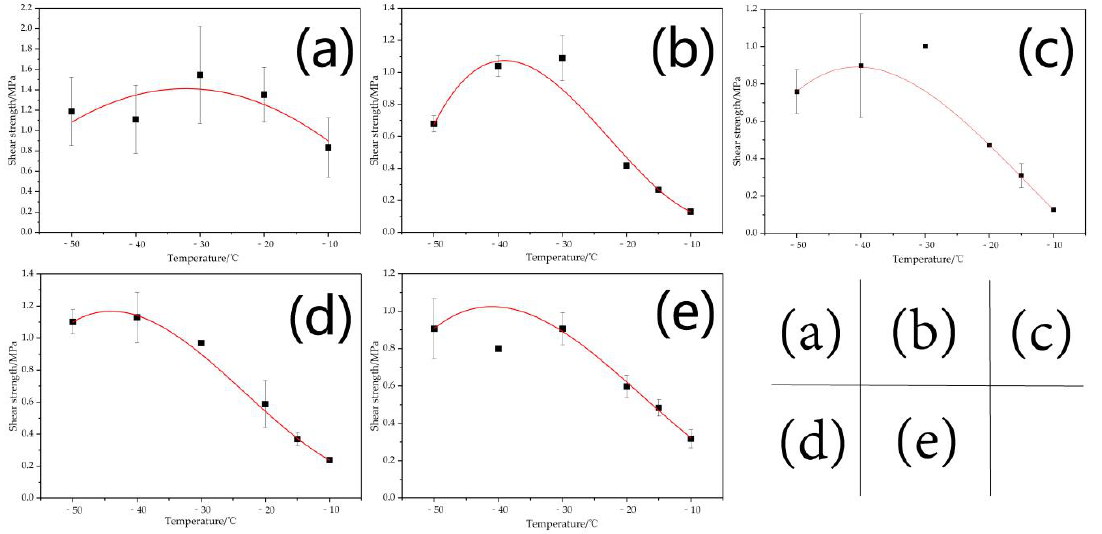
Figure 20. Shear strength results. Shear strengths of ( a ) freshwater ice, ( b ) Dalian seawater ice, ( c ) Qingdao seawater ice, ( d ) Fuzhou seawater ice, and ( e ) Zhuhai seawater ice are shown.